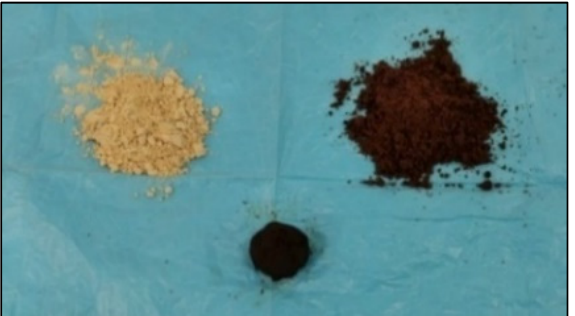
Figure 2. Types of smokeless tobacco powder used in this study. Raw powder and formed bulla can be seen.